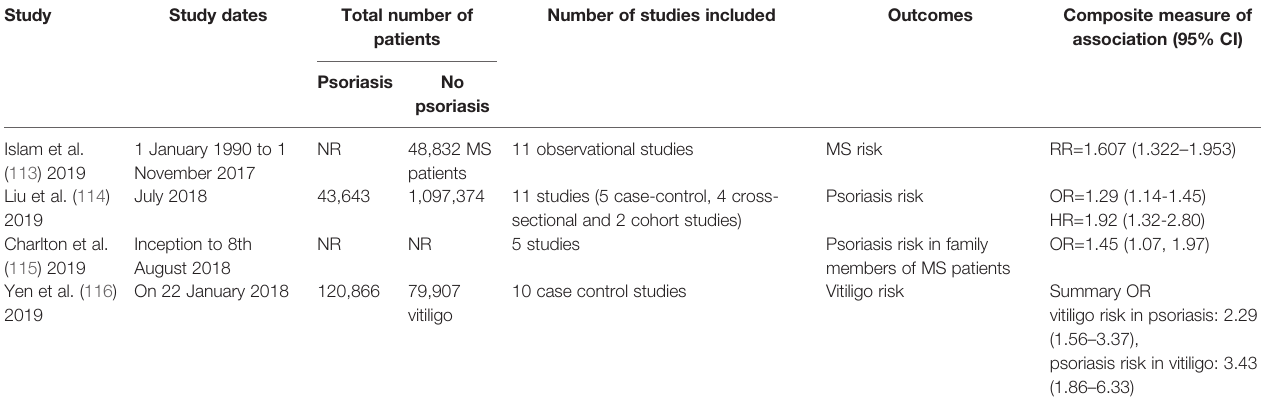
TABLE 4 | Summary of systematic review and meta-analyses assessing the association between psoriasis and MS and